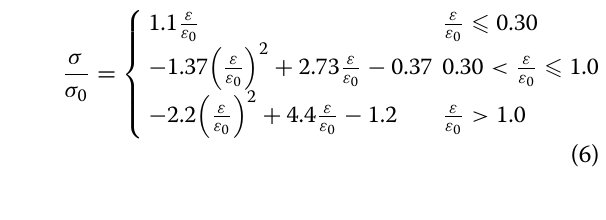
Fig. 11 Normalized stress–strain relationship test curve and fitting